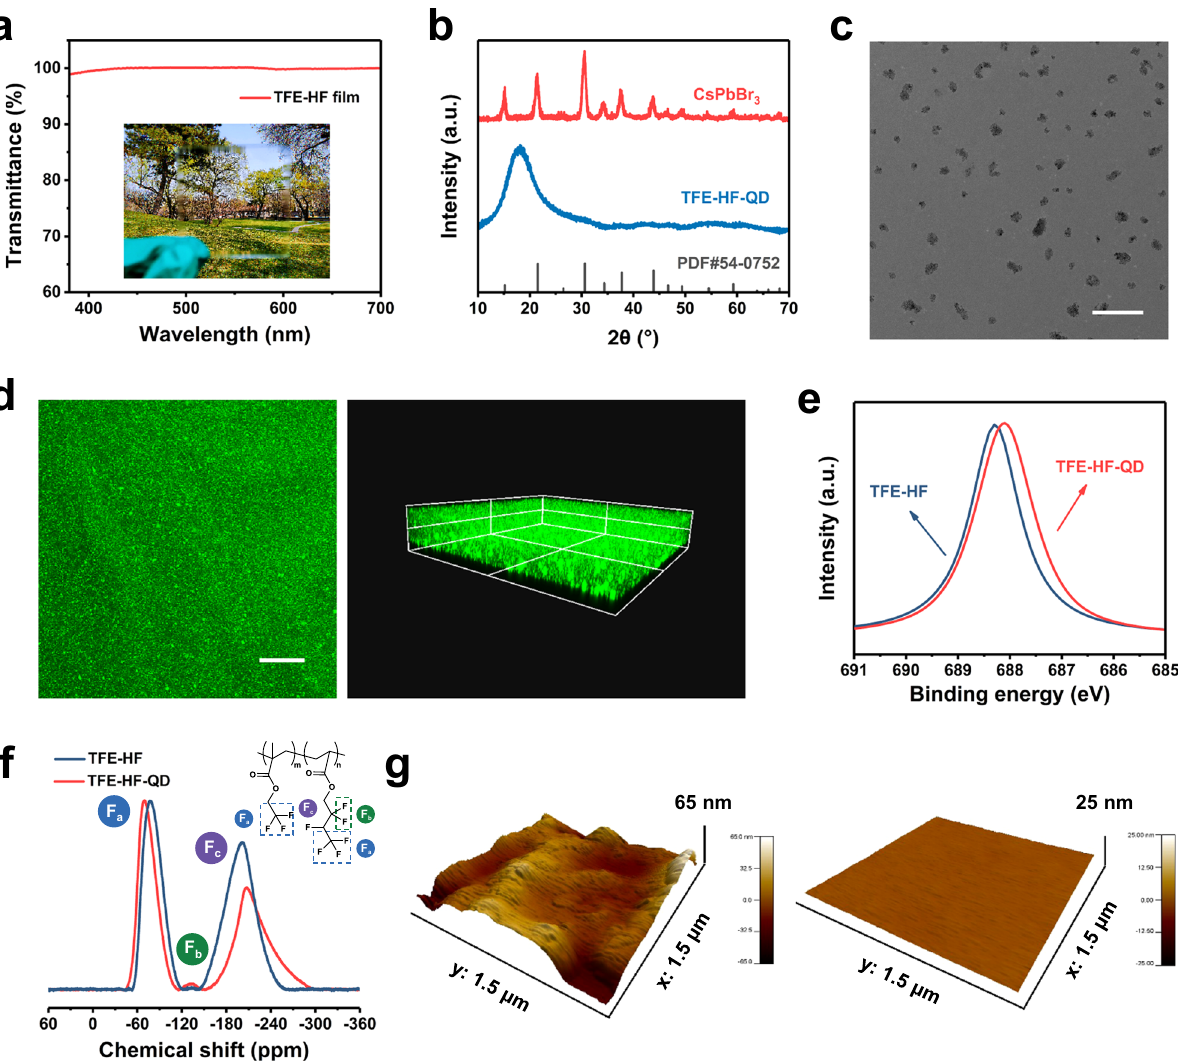
Fig. 2 Structural characterization of TFE-HF and TFE-HF-QD. a Transmittance spectra of TFE-HF fi lm (0.2 mm) in the photo. b The XRD patterns of CsPbBr 3 , TFE-HF-QD and the standard patterns of pure CsPbBr 3 . c A typical TEM image of TFE-HF-QD. Scale bar, 0.5 μ m. d Fluorescence images of TFE- HF-QD fi lm with an excitation wavelength of 488 nm. Scale bar for 2D image, 200 μ m. e F 1 s spectra of pure TFE-HF and TFE-HF-QD composite fi lms. f 19 F SSNMR spectra of pure TFE-HF and TFE-HF-QD composite fi lms. g AFM images of the CsPbBr 3 fi lm (left) and TFE-HF-QD fi lm